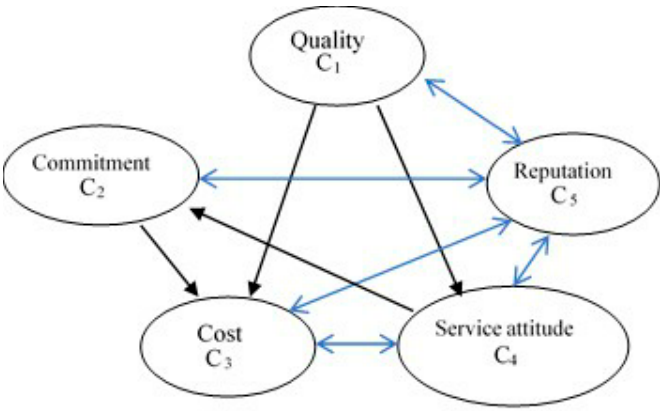
Figure 4. Relationships among CBPPM supplier selection criteria. Table 4. Relationships among CBPPM supplier selection subcriteria.